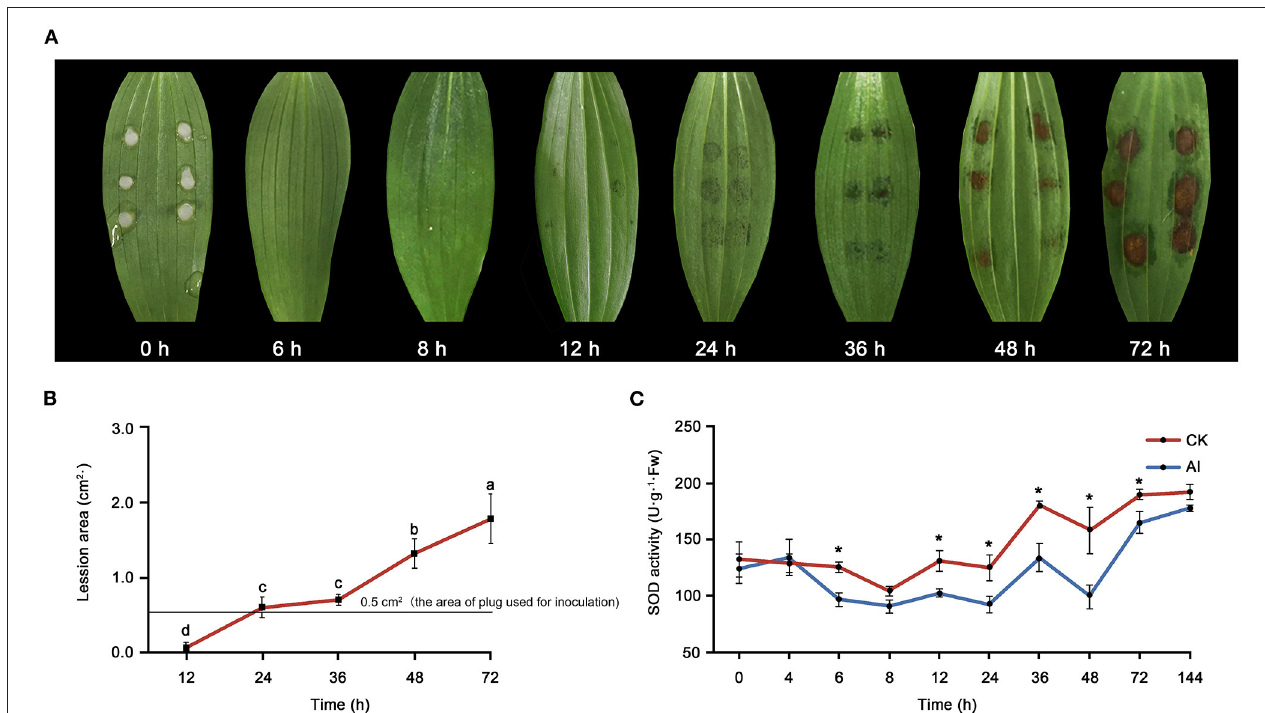
FIGURE 1 | Evaluation of the response of Lilium oriental high resistant hybrid “Sorbonne” to Botrytis elliptica inoculation. (A) Progression over time (0–72 hpi) of symptoms on B. elliptica inoculated Sorbonne leaves. Each leaf is representative of nine repetitions. (B) Change in lesion area over time. Data represent mean ± standard error (SE) of triplicate assays. (C) Changes in super oxide dismutase (SOD) activity over time. Data represent mean ± SE of triplicate assays. The line charts were generated based on IBM SPSS Statistics 20. The “*” represents the significant differences in the SOD activity.